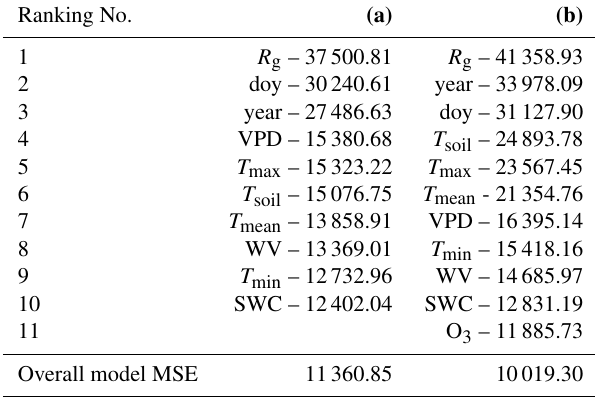
Table 3. The ranking of the parameters defining GPP in the ANN by replacing each input variable with a random permutation of its values. (a) The parameters with their mean square error (MSE; molm − 2 day − 1 ) for the model without O 3 . (b) The parameters with their MSE for the model with O 3 . The overall model MSE without any random permutation is also